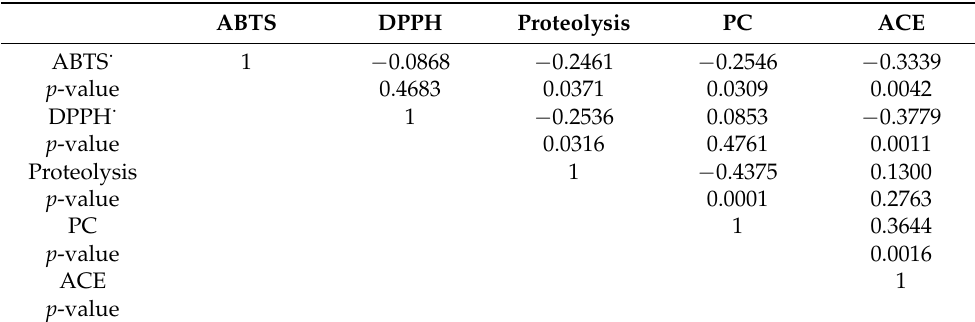
Table 5. Correlation between the response variables of requeson cheese.